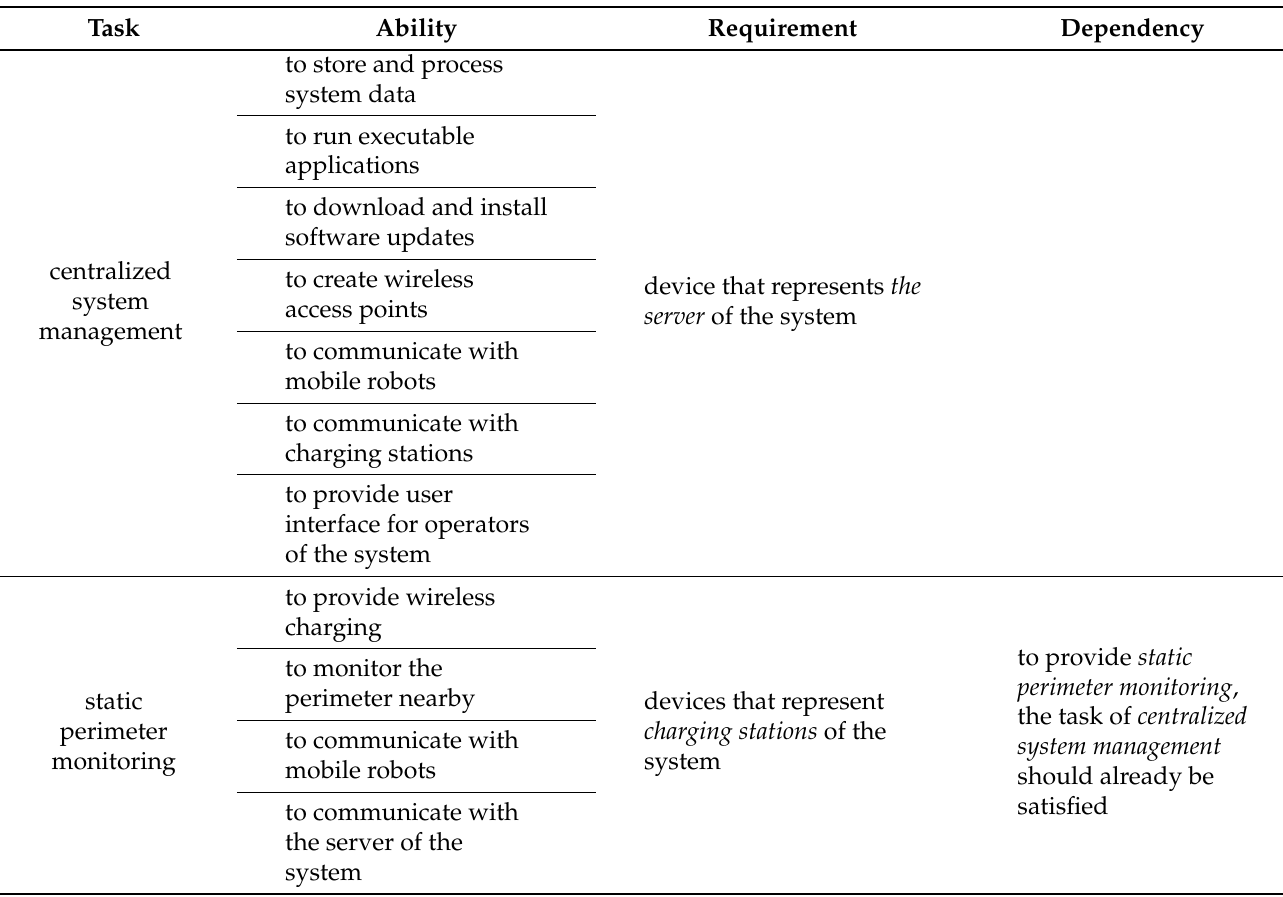
Table 8. Tasks, abilities and requirements of the designed